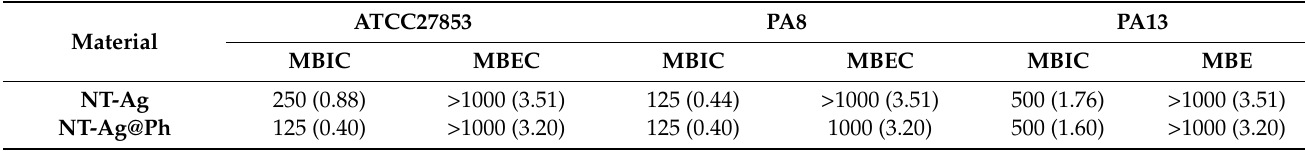
Table 4. Minimum biofilm inhibitory concentration (MBIC) and minimal biofilm eradication concen- tration (MBEC) for NT-Ag and NT-Ag@Ph against three different P. aeruginosa strains. Data are given in µ g/mL of material, and data in brackets refer to the µ g/mL of silver.